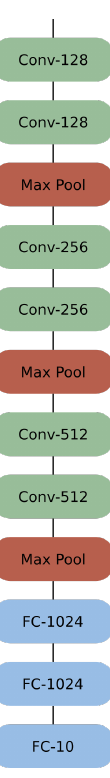
Figure 2. Topology of the original Binarized Neural Networks (BNN). Numbers listed denote the number of output channels for the layer. Input channels are determined by the number of channels in the input, usually 3, and the input size for the FC layers.